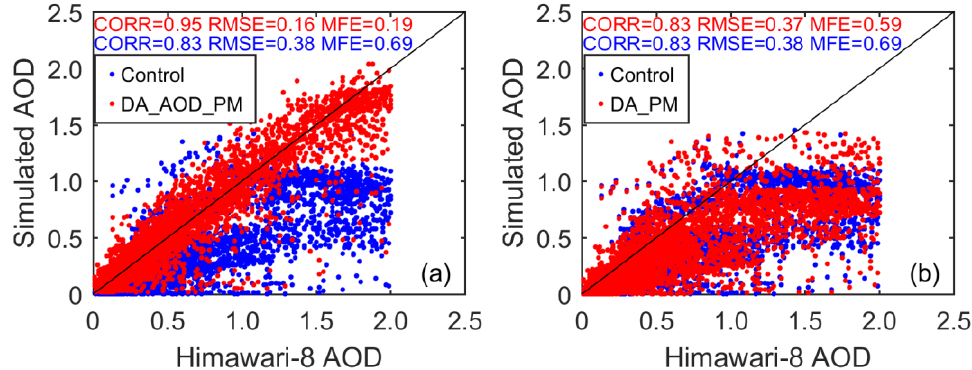
Figure 5. Comparison between the AOD measurements and the AOD in ( a ) the control IC (blue points) and Da_AOD_PM analysis (red points). ( b ) Control IC (blue points) and Da_PM analysis (red points).